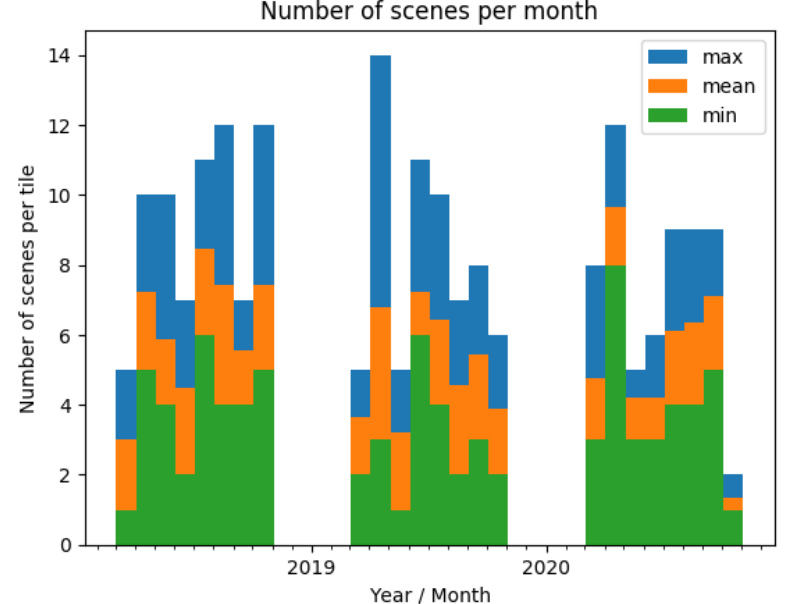
Figure 3. Distribution of available Sentinel-2 images per month for the area of nine tiles constrained by a cloud coverage < 80% and excluding winter months; only March to October scenes are